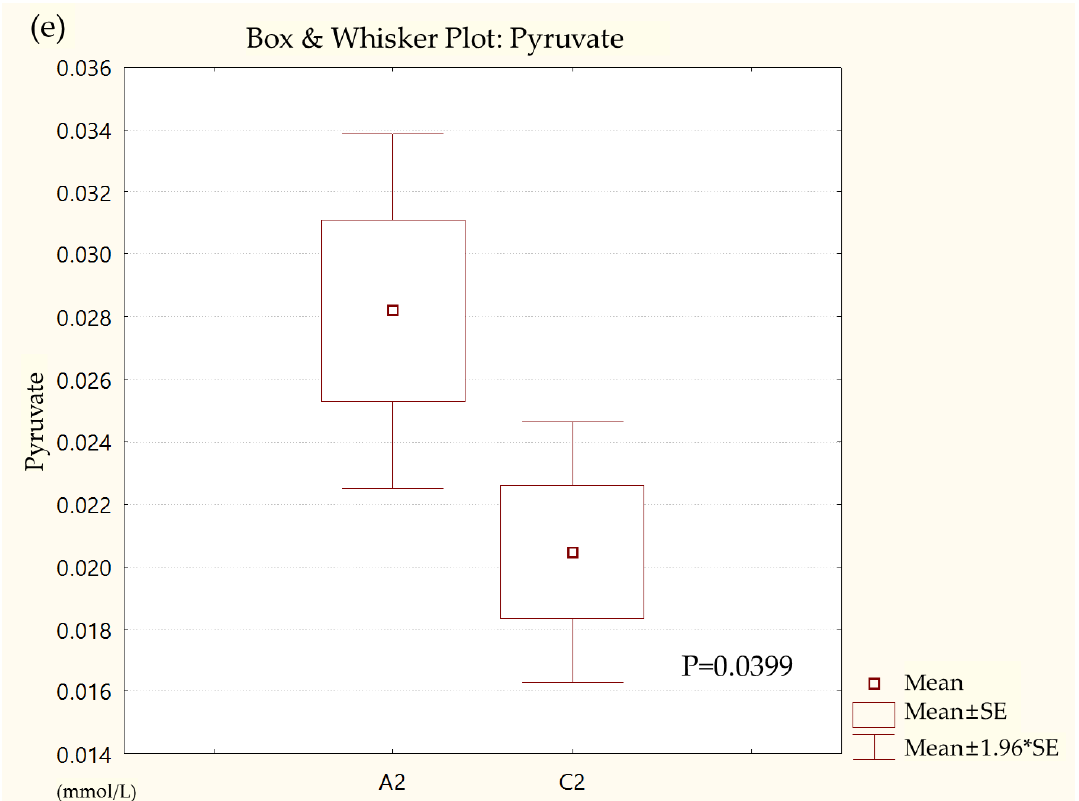
Figure 5. Box and whisker plot of ( a ) formate, ( b ) glycolate, ( c ) trimethylamine, ( d ) valine, and ( e ) pyruvate in ulcerative colitis (UC) patient group and healthy control (HC) group. A2, ulcerative colitis patient group; C2, healthy control group.